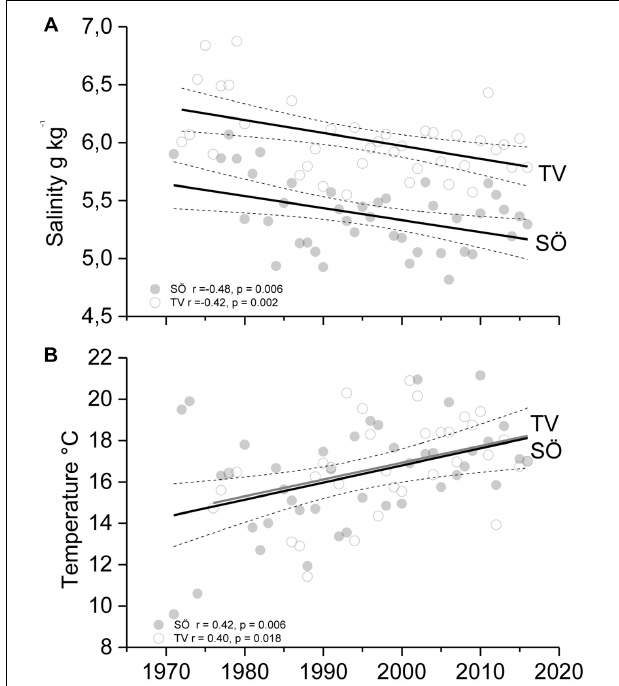
FIGURE 2 | Long-term salinity (A) (annual mean) and temperature (B) (August) trends with 95% confidence intervals at Tvärminne (TV) and Söderskär (SÖ) in the western and central Gulf of